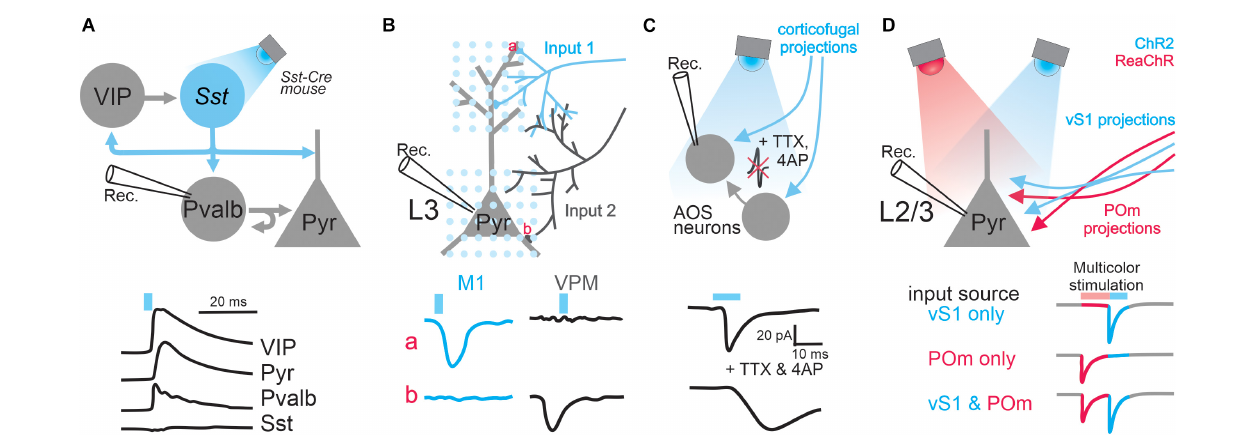
FIGURE 1 | Applications of optogenetics in the analysis of circuit connectivity. (A) The examination of the connection from Sst positive GABAergic interneurons to excitatory pyramidal neurons and various types of GABAergic interneurons by photo-stimulating Sst neurons expressing ChR2. Top, schematic of experimental design; bottom traces, example IPSCs received by different types of cells upon Sst activation. (B) Subcellular ChR2-assisted circuit mapping (sCRACM) to reveal subcellular organization of two different long-range inputs impinged onto L3 pyramidal neurons. Bottom traces, example EPSCs when stimulating M1 or VPM inputs at particular domains (a, the tuft branches; b, basal dendrites). (C) The examination of corticofugal innervation onto brainstem AOS neurons by pharmacologically blocking action potentials. Bottom traces: example EPSCs before and after blocking action potentials. (D) Dual-channel mapping to resolve two different inputs received by L2/3 pyramidal neurons. ChR2 and ReaChR are expressed in axons coming from vS1 and POm, respectively. Bottom traces, the colored segments represent the EPSC components mediated by activating POm input or vS1 input. The blue or pink bars above traces represent light